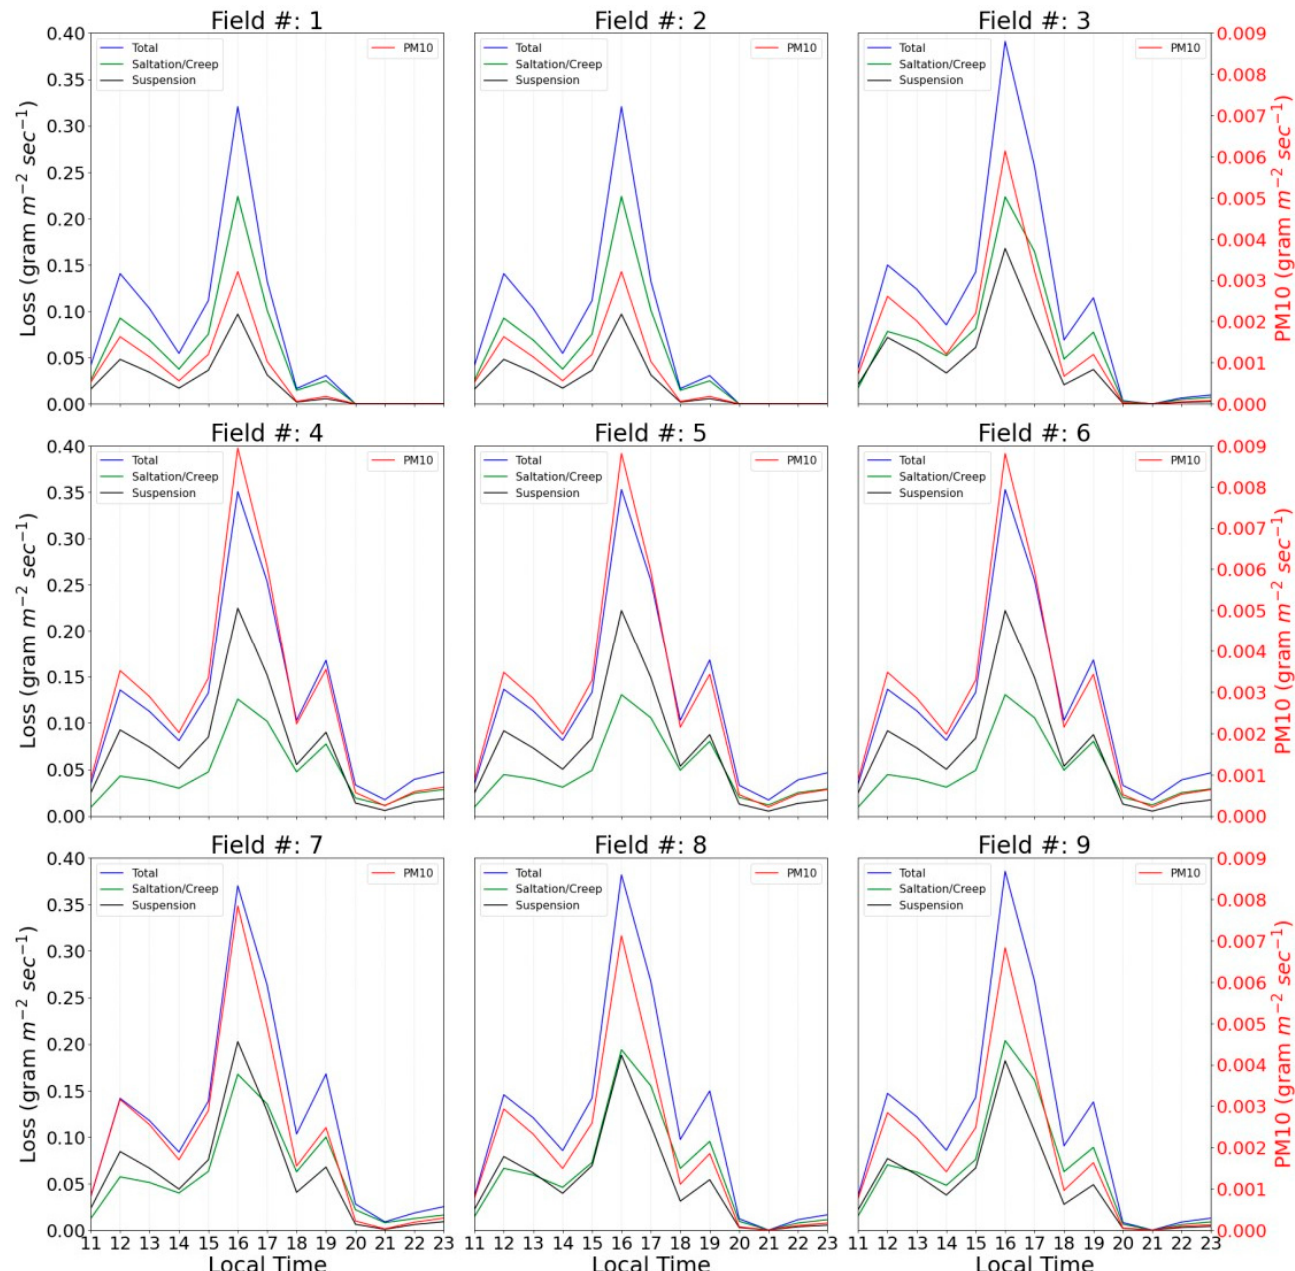
Figure 10. SWEEP simulated soil loss, in terms of the total, saltation/creep, suspension, and PM 10 from the Road Forks Playa field during the dust event of 3 February 2020. The left y-axis represents the total, saltation/creep, and suspension loss, and the right y-axis (twin y-axis) represents PM 10 .